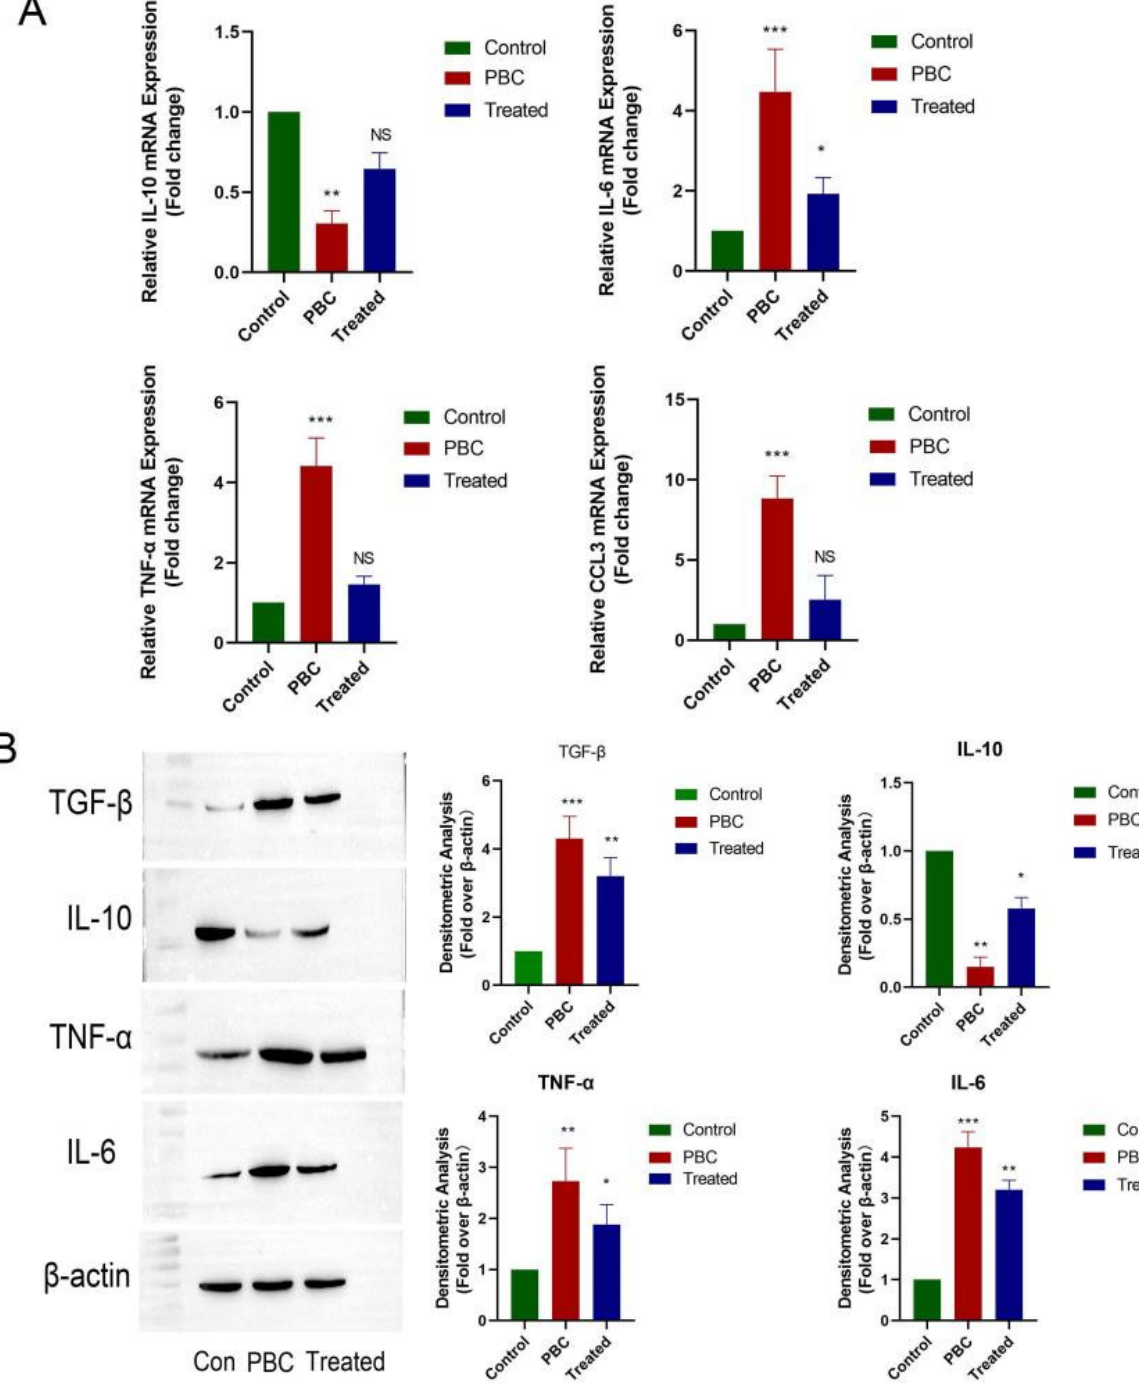
Figure 4. Changes in inflammatory cytokine levels in vivo. ( A ) mRNA levels of IL-6, TNF- α , IL-10, and CCL3. ( B ) Protein levels of TGF- β , IL-10, TNF- α , and IL-6 relative to controls ( n = 3/group). * p < 0.05, ** p < 0.01, and *** p < 0.001. NS: no significance.